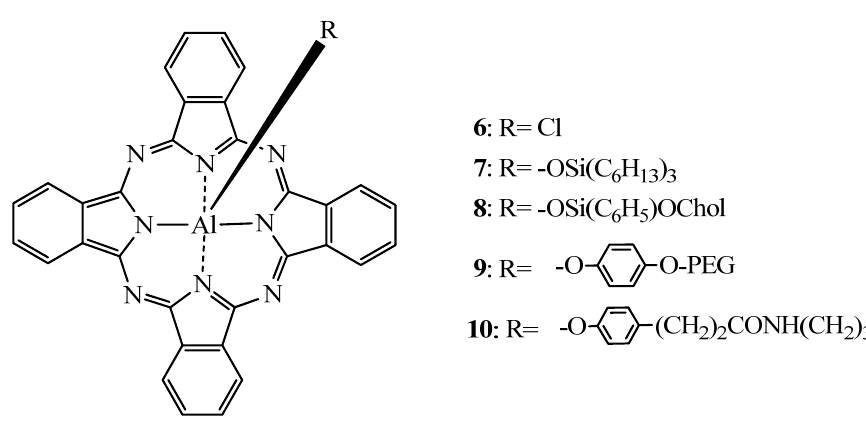
Figure 5. Chemical structure of AlPc 6–10